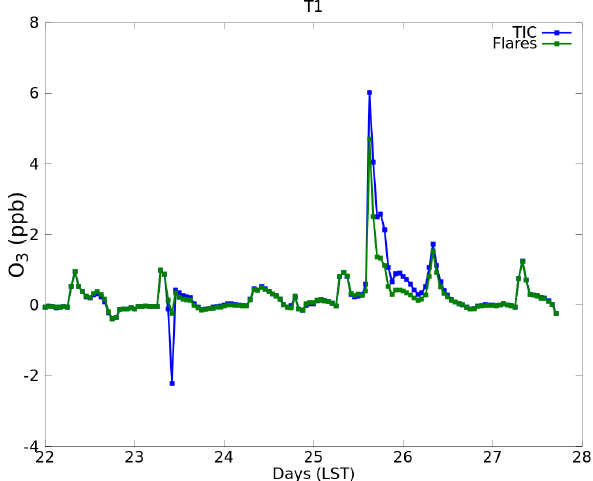
Table 3. Scenarios of SO 2 emission reductions in the TIC (MHR + FPRPP) and in the MCMA involving the New Bicentenario Re- finery. Units are in kgs − 1 . Baseline case assumes no reductions in the MHR and FPRPP. All scenarios include MCMA